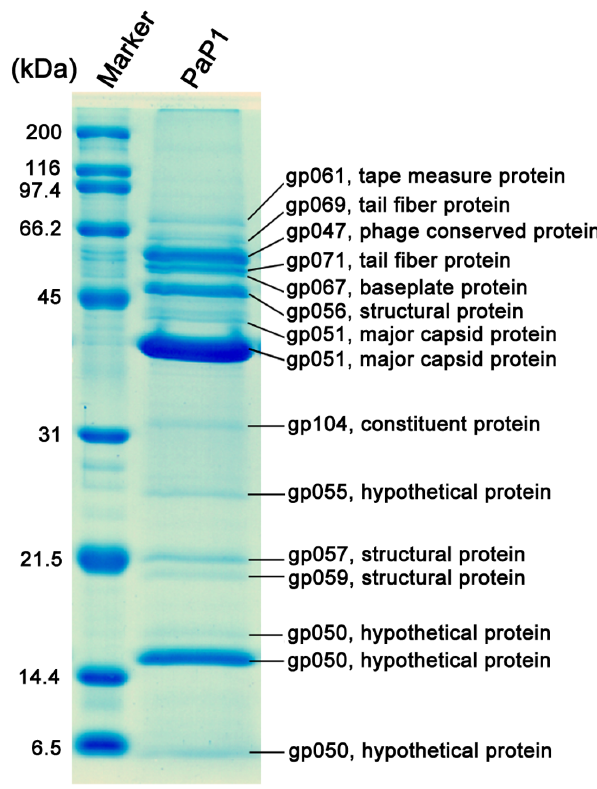
Figure 7. SDS-PAGE analysis of the structural proteins of phage PaP1. Proteins were visualized in a 15% (w/v) gel and identified by